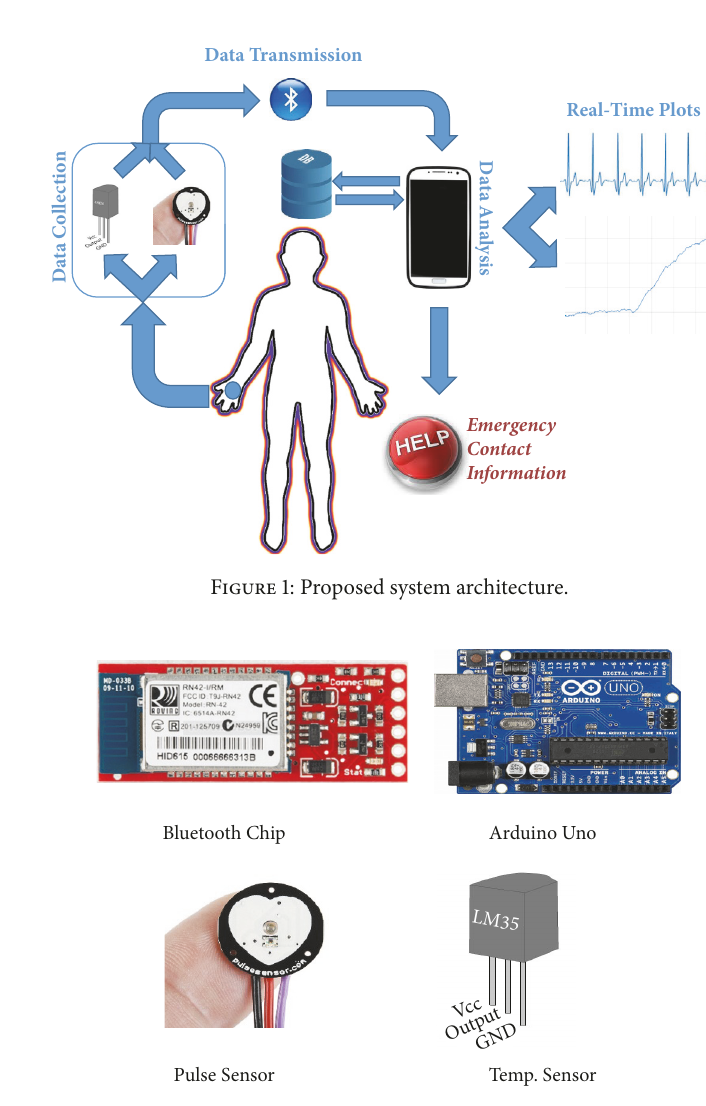
Figure 2: Hardware components for early prototype system